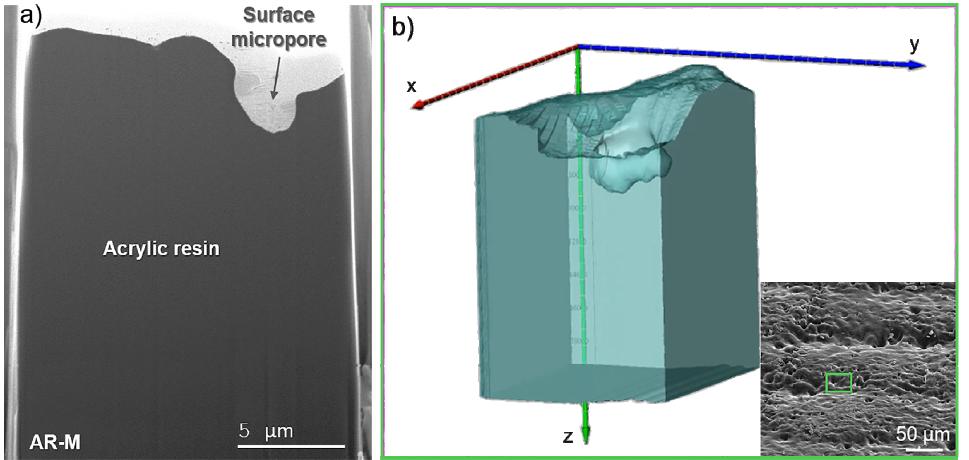
Figure 4. ( a ) SEM image and ( b ) slice and view FIB-SEM tomography of sample AR-M. The inset displays an SEM image with a green rectangle pointing out the area studied.